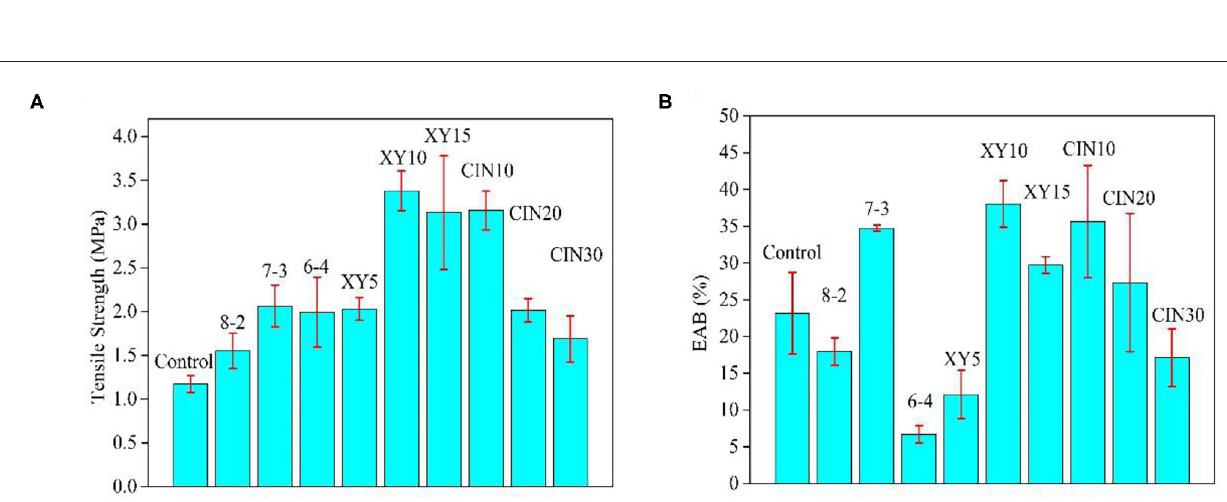
Frontiers in Nutrition |